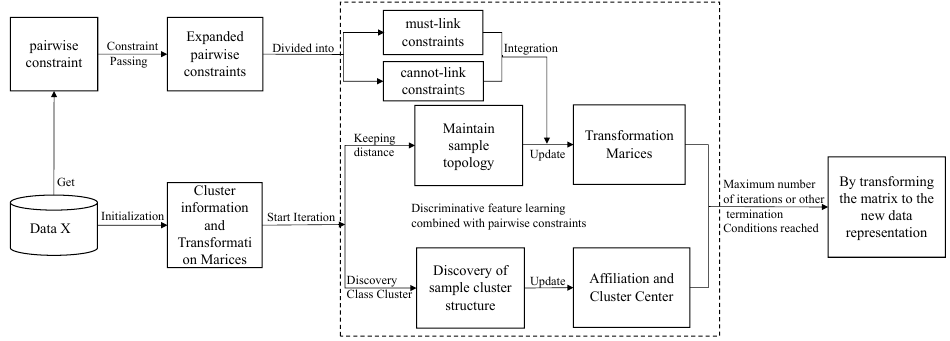
Figure 1. The overall process of discriminative multidimensional scalar learning based on pair- wise